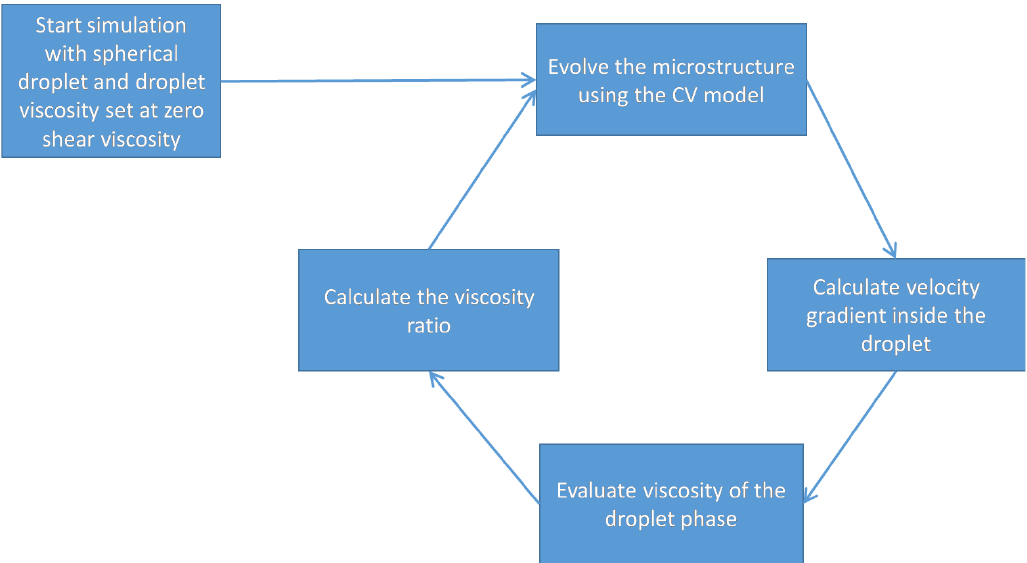
Figure 1: Schematic illustrating the cyclical dependence between droplet evolution and viscosity of droplet phase for a shear thinning droplet fluid.